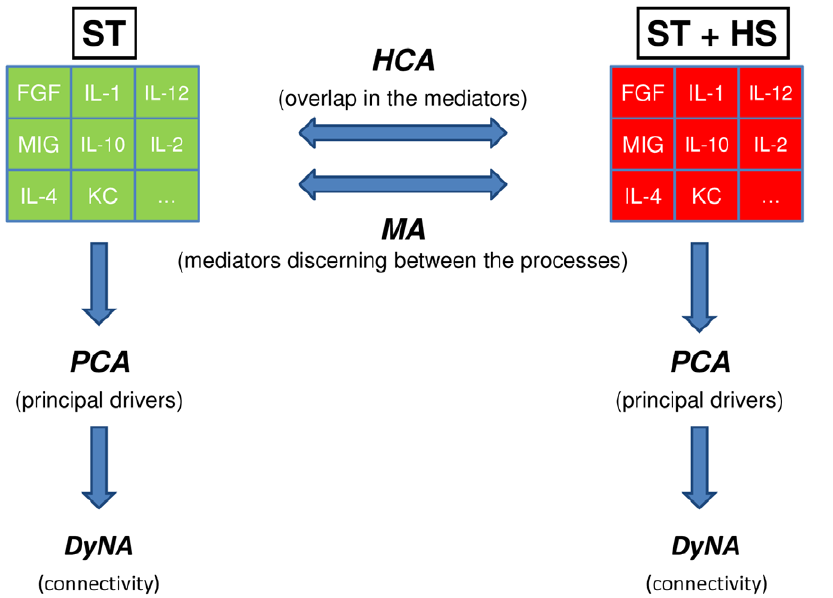
Figure 1. Schematic of analyses utilized in the present study. Mice were subjected to ST 6 HS followed by measurement of cytokines, chemokines, and NO 2 2 /NO 3 2 as described in the Materials and Methods .